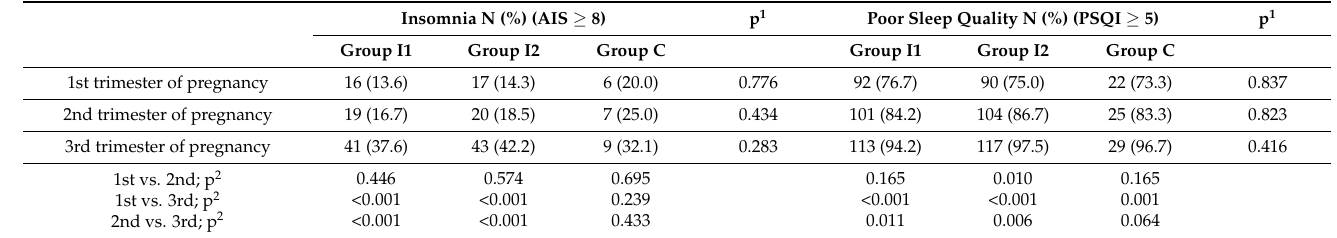
Table 4. Prevalence of insomnia and poor quality of sleep throughout pregnancy.